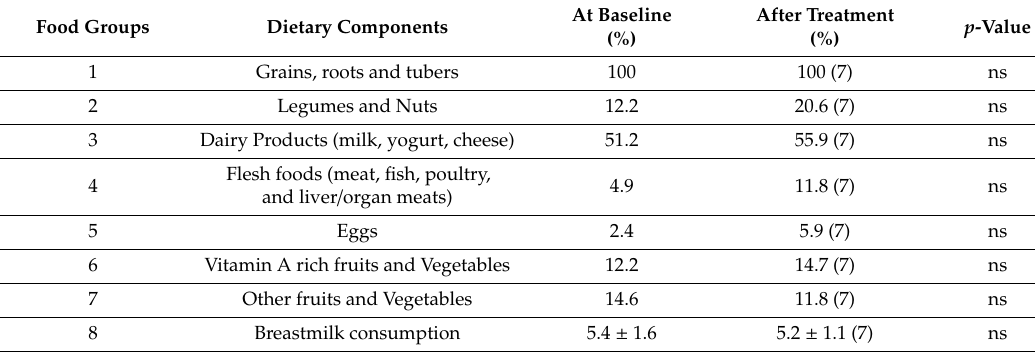
Table 3. Study participants (%) by food group at baseline and after treatment with